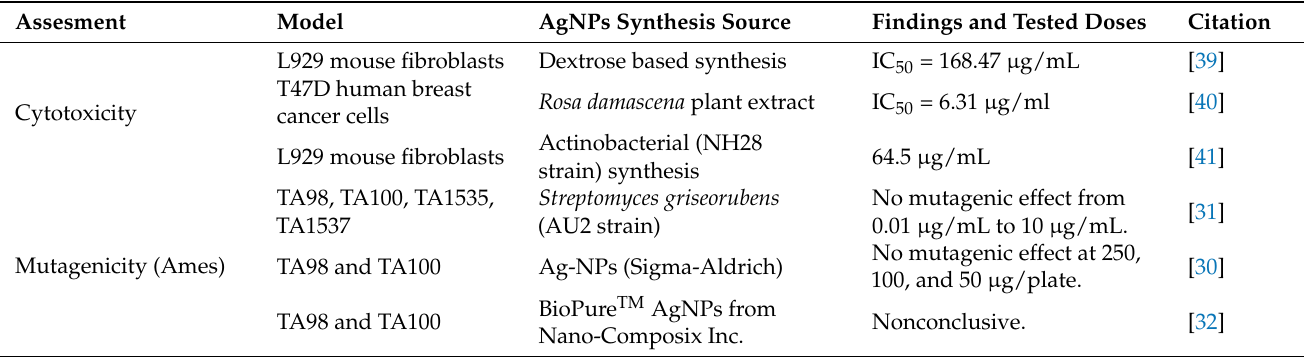
Table 12. Previous findings on the safety assessment of silver